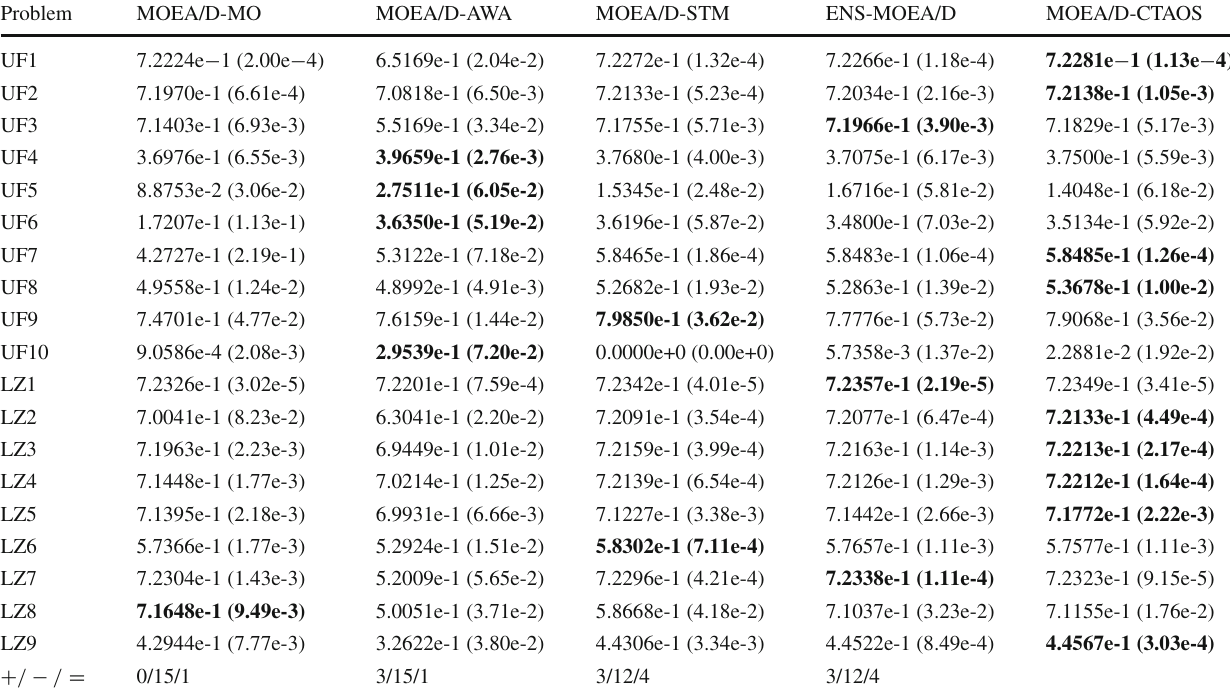
Table 2 Average and standard deviation HV values obtained by MOEA/D variants on each benchmark (30 runs)